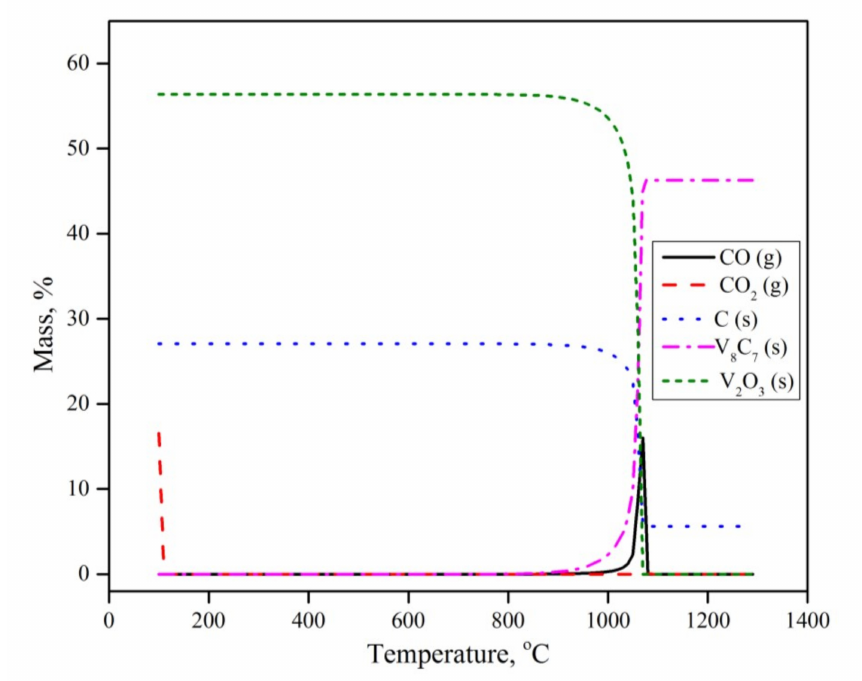
Figure 7. Thermodynamic calculations using